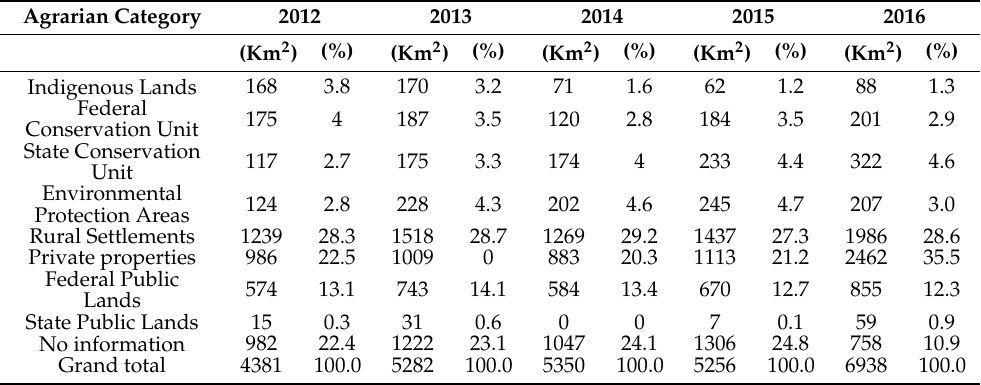
Table 1. Deforested area in the Amazon by land title category from 2012 to 2016. Adapted with permission from [8] Moutinho et al. (2016).